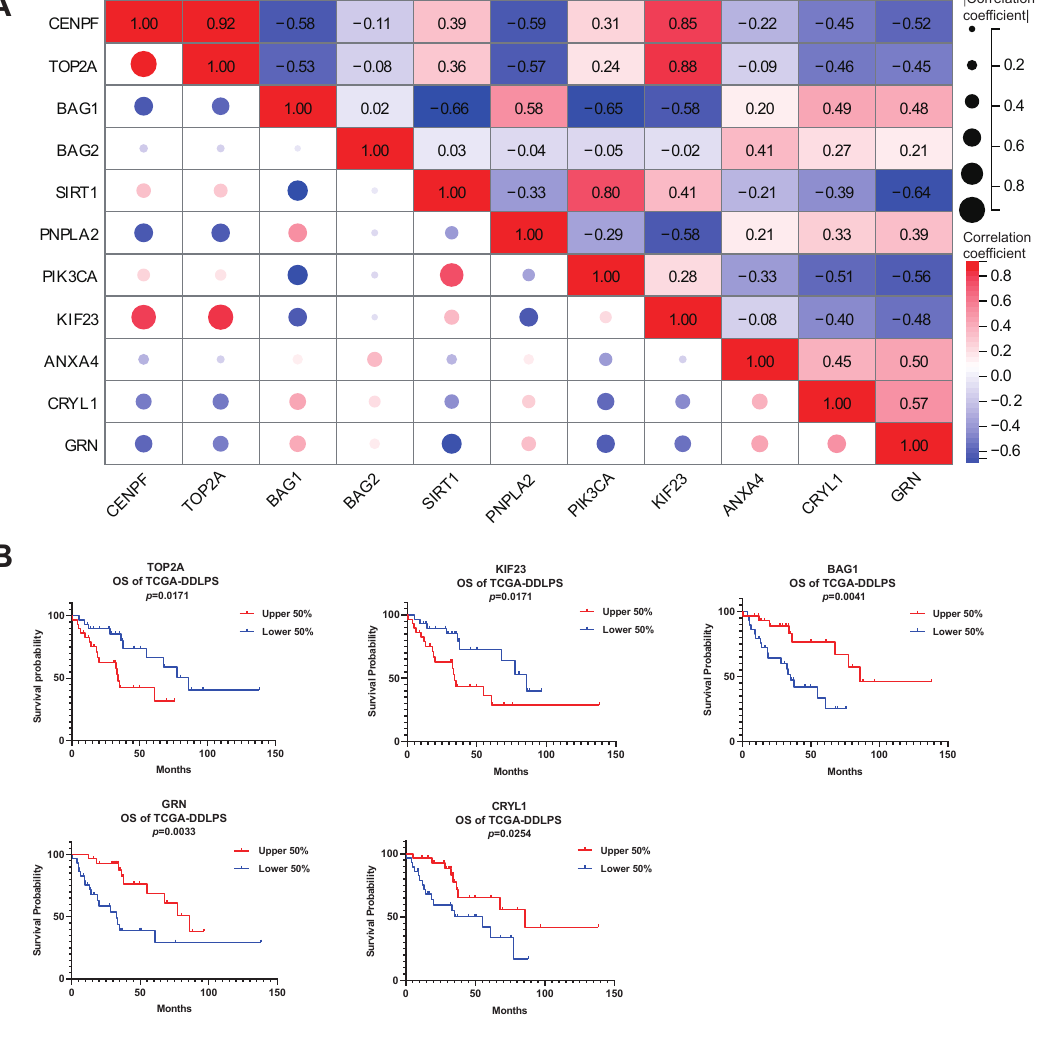
Figure 4. Correlation analysis between CENPF and previously reported DEGs or biomarkers of LPS. ( A ) Correlation matrix was plotted by Pearson’s rank correlation test with circles representative of the significance of the correlation. Negative and positive correlation were indicated by blue and red boxes, respectively. Color intensity and absolute value of correlation coefficient were directly proportional to the correlation intensity. ( B ) Validation of the prognostic values of known DEGs or biomarkers of LPS relevant to CENPF (|correlation coefficient| > 0.4) by survival curves. OS: overall survival; DDLPS: dedifferentiated liposarcoma; DEGs: differentially expressed